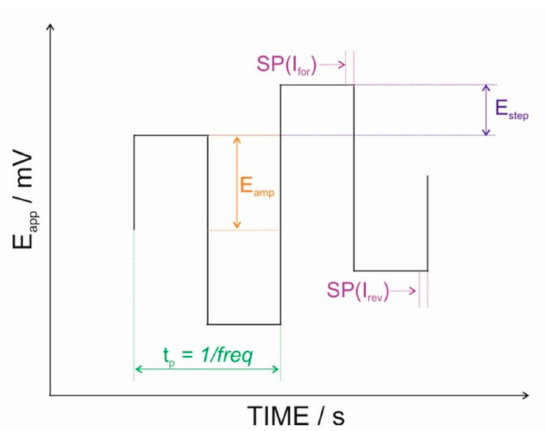
Figure 5. Square-wave waveform showing the meaning of pulse amplitude (E amp ), pulse step (E step ), frequency (freq), and sampling period (SP) at I for (forward current) and I rev (reverse